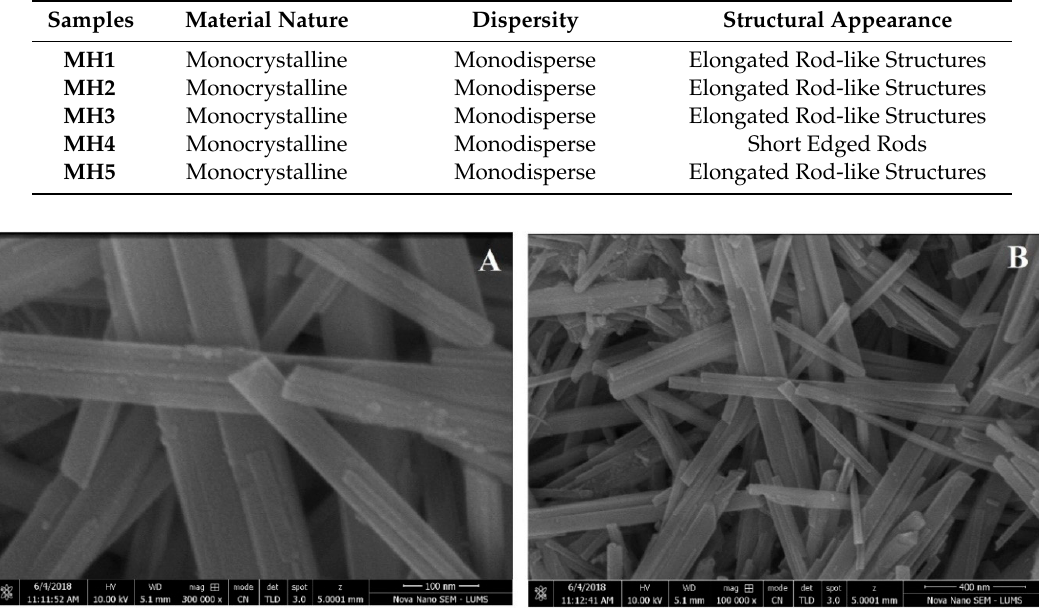
Figure 2. SEM images of the representative sample MH5 (( A ) (100 nm) and ( B ) (400 nm)).